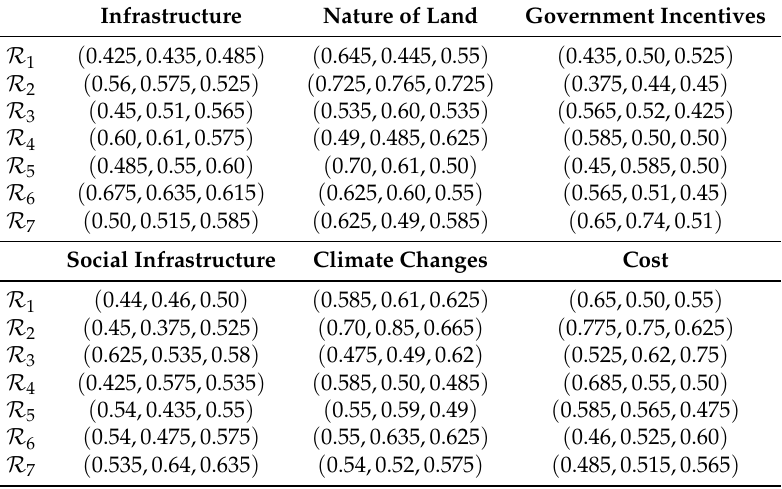
Table 7. Aggregated decision values of